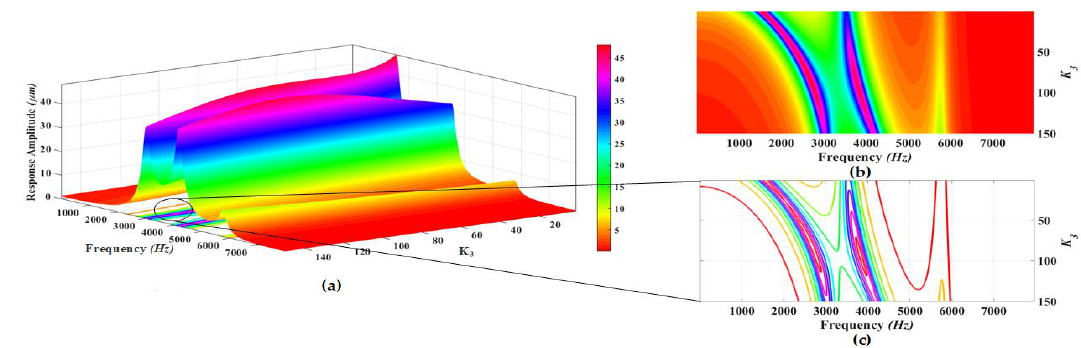
Figure 12. ( a ) Response amplitude and bandwidth optimization graph for the variation of 𝑘 3 ; ( b ) Top view and ( c ) Contour plots of the system response.